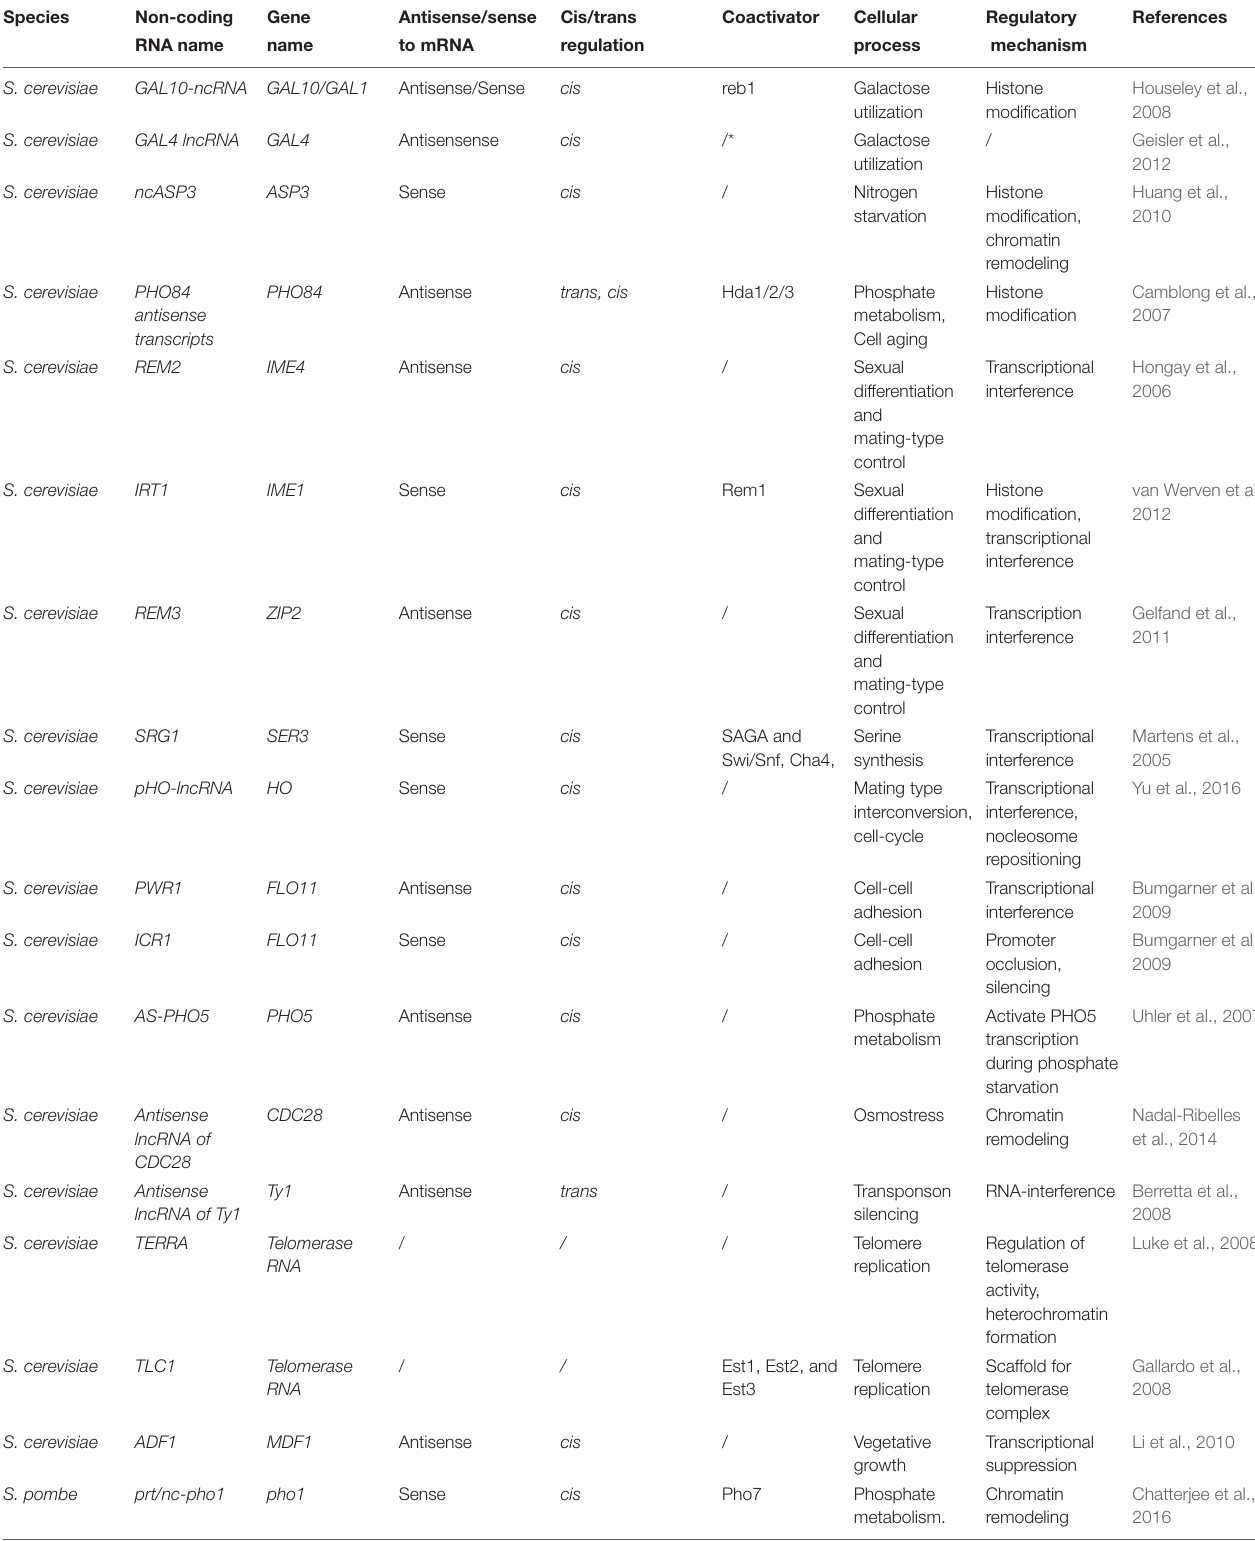
TABLE 2 | Experimentally characterised lncRNAs in